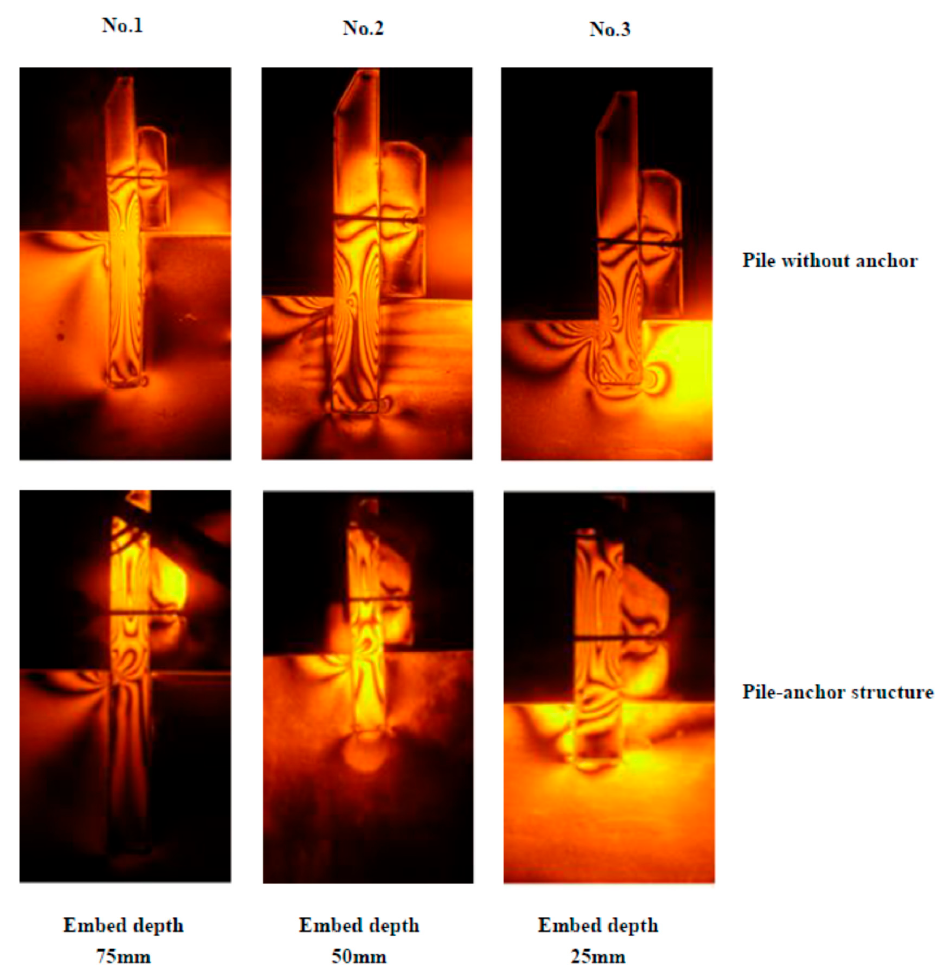
Figure 9. Isochromatic fringe of epoxy resin pile.